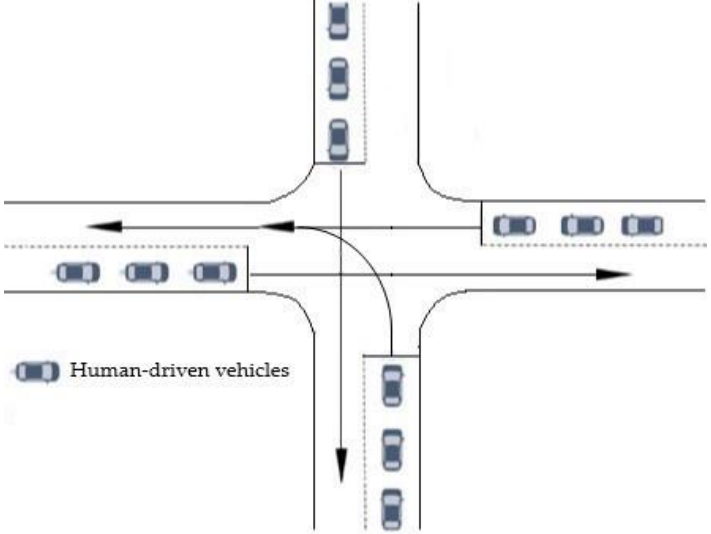
Figure 5. The entirely human-driven vehicle experiment in the context of a non-signalized intersec- tion.